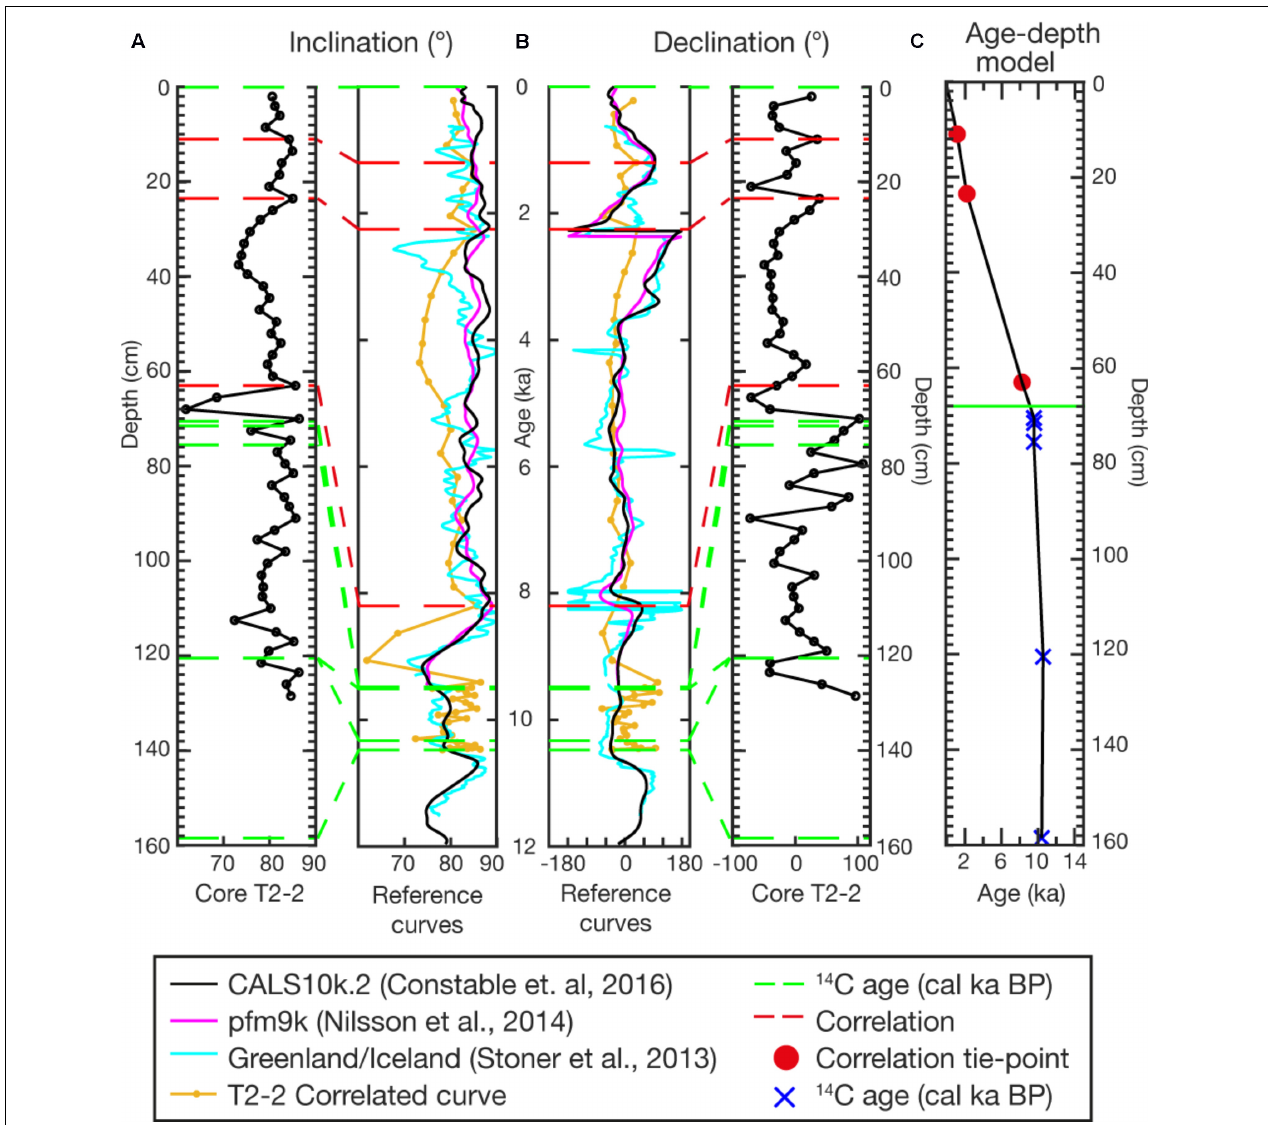
FIGURE 5 | Correlation of paleomagnetic measurements of (A) inclination and (B) declination in Core T2-2 to three reference curves (see Legend). Stippled lines indicate correlation points. Green stippled lines are constraints based on 14 C ages. The resulting age-depth model for core T2-2 is shown in (C)